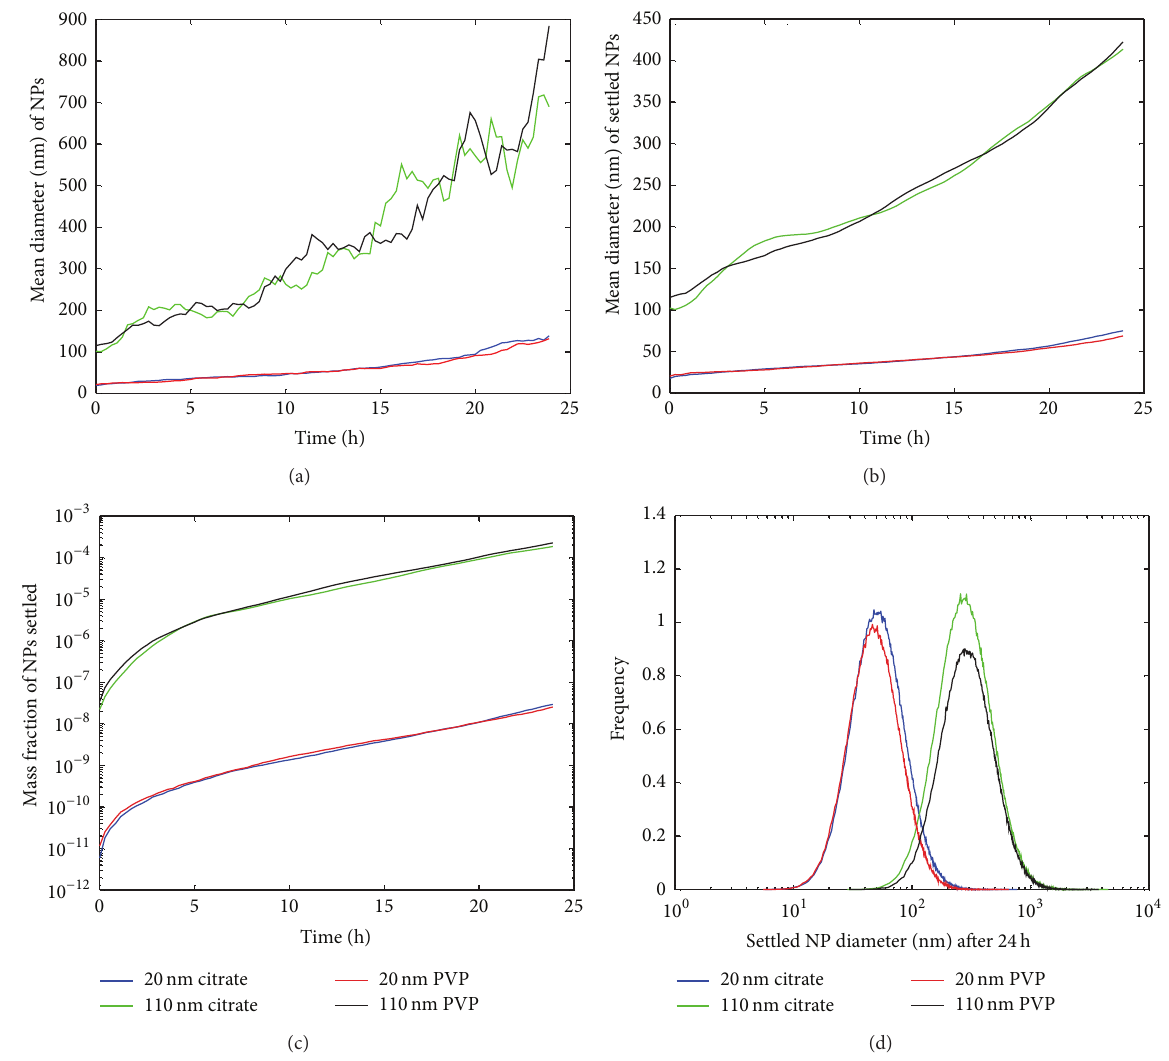
Figure 5: Model predictions from ADSRM for transformation processes of 4 different types of nAg in cell culture media over 24 hours; (a) mean diameter of all NPs in the medium over the time span of 24 hours, (b) mean diameter of NPs settled at the bottom of the culture plate, (c) mass fraction of nAg settled, and (d) size distribution of nAg settled. ((a) and (c) reproduced from Mukherjee et al. [18] with permission).